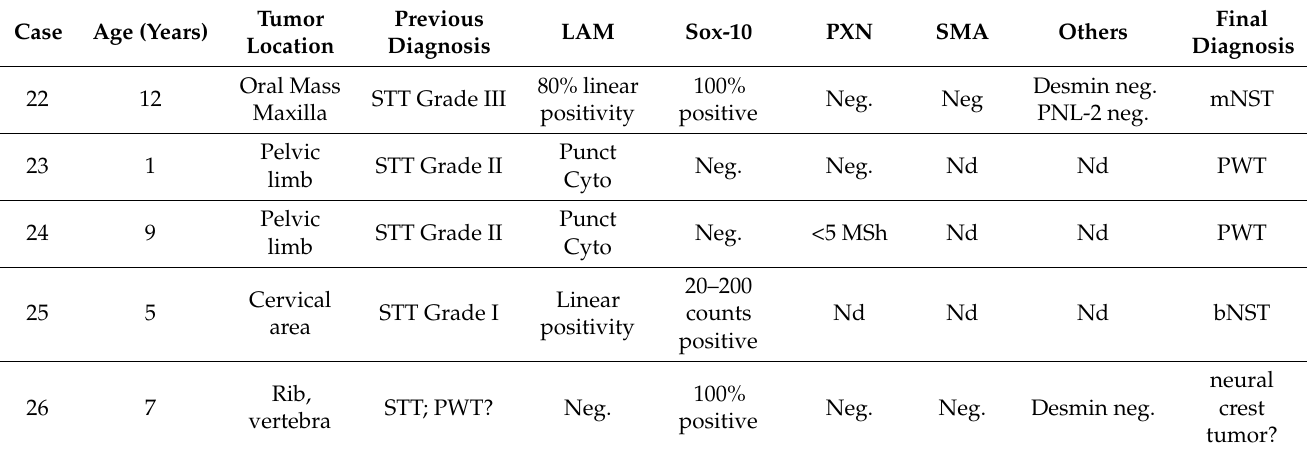
Table 3. Evaluation of five STT with antibody panel to achieve a more specific diagnosis.